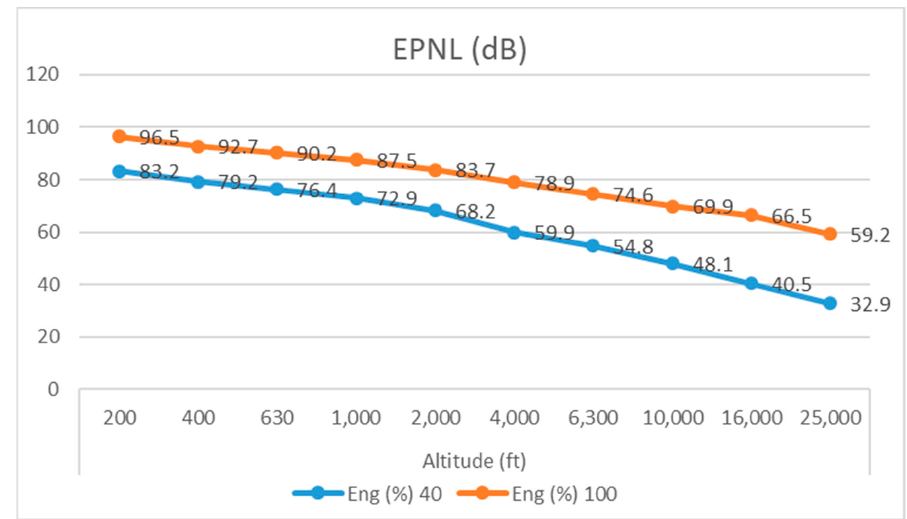
Figure 32. NPD curves, in terms of EPNL, for the ATR configuration.